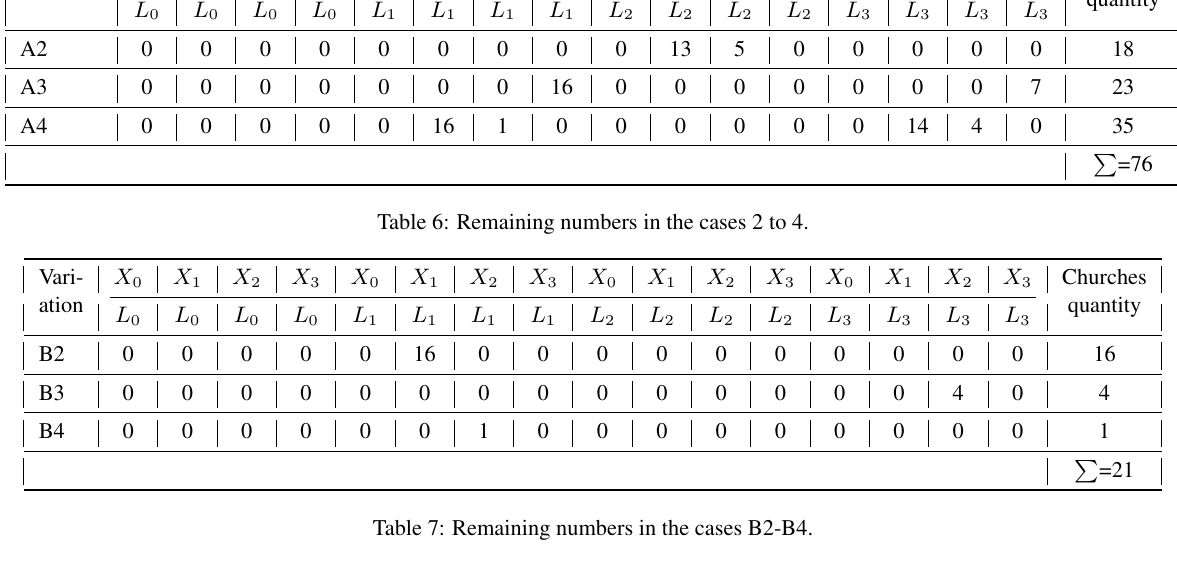
Table 7: Remaining numbers in the cases B2-B4.